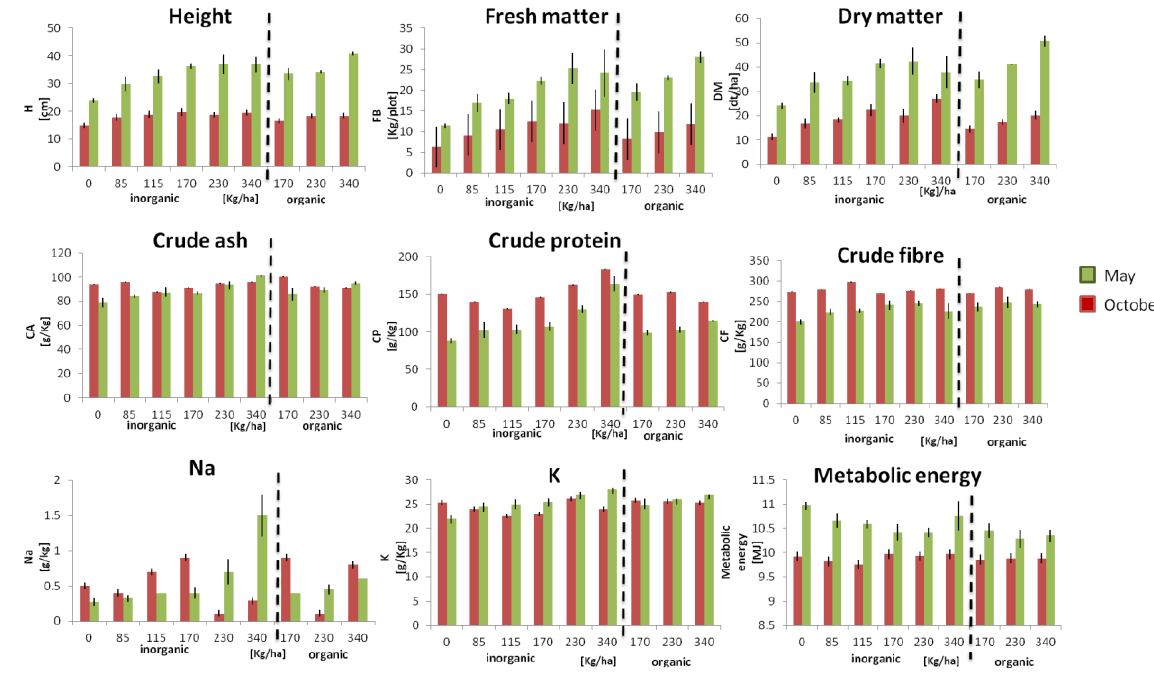
Figure 4. Influence of the type and the amount of fertilizer treatment on grassland traits and their standard deviations.